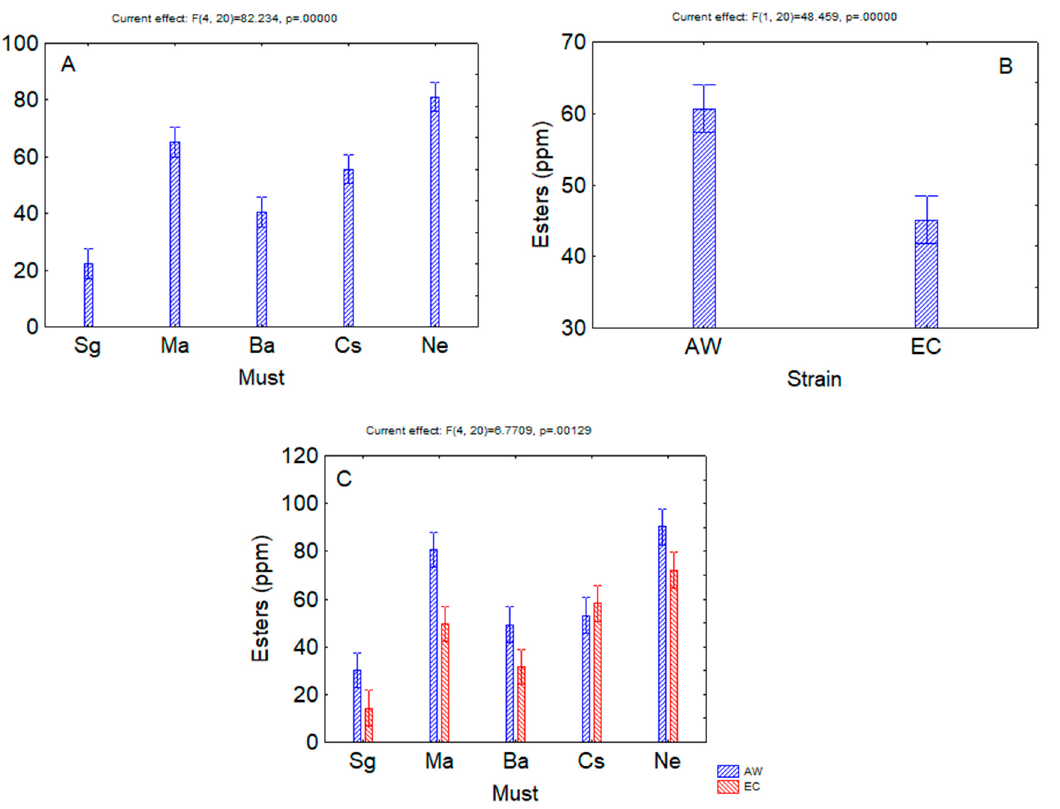
Figure 2. Decomposition of the statistical hypothesis for the effects of must ( A ), strain ( B ), and interaction must × strain ( C ) on the total amounts of esters. Bars denote 95%-confidence intervals. Sg, Sangiovese; Ma, Magliocco; Ba, Barbera; Cs, Cabernet-Sauvignon; Ne, Negroamaro. EC, strain EC1118; AW, strain